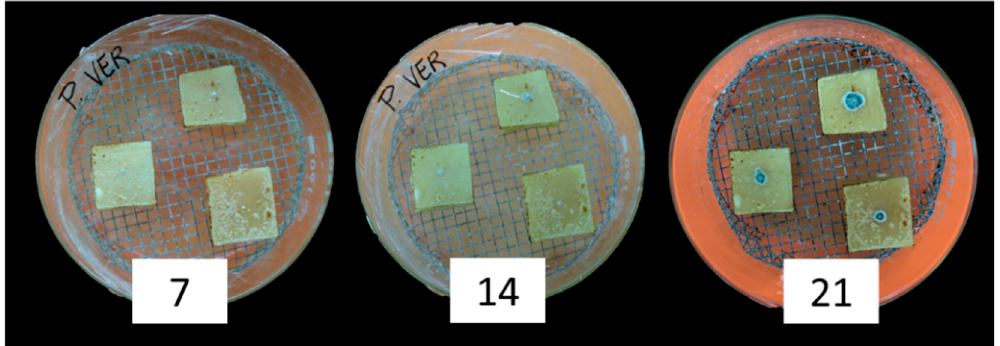
Figure 1. Growth of Penicillium verrucosum inoculated on cheese blocks (triplicate) after 7, 14, and 21 days of incubation at 25 °C with 0.93 water activity ( a w ).